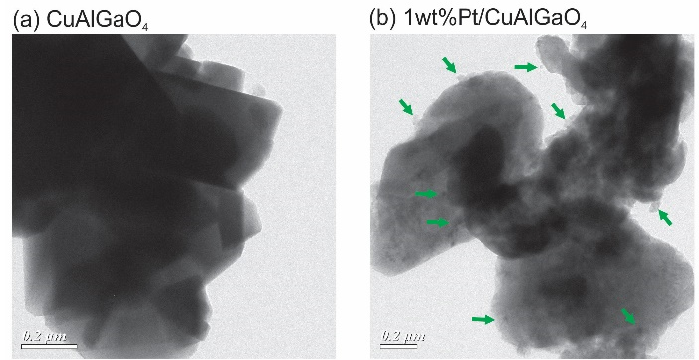
Figure 4. Transmission electron microscopy (TEM) images of photocatalysts: ( a ) CuAlGaO 4 and ( b ) 1 wt % Pt/CuAlGaO 4 photocatalysts.